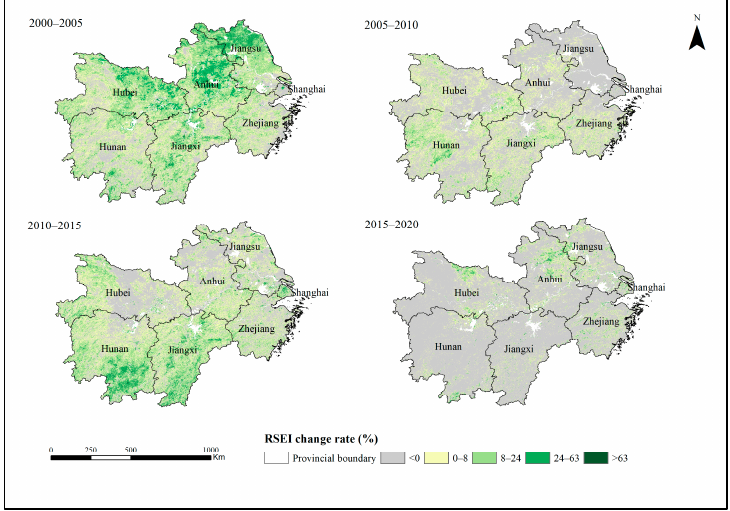
Table 4. The goodness-of-fit index of the hypothetical model. Fit Goodness